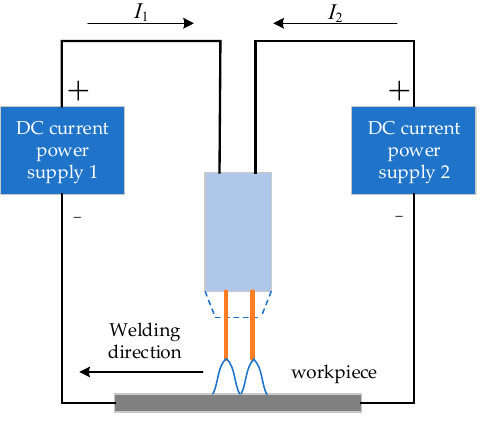
Figure 1. Tandem welding process.